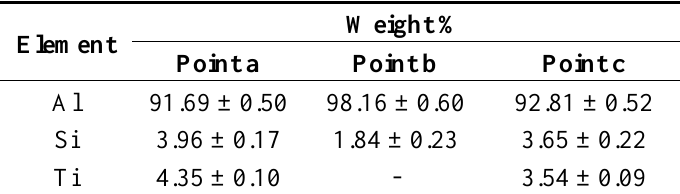
Figure 6. TEM image of A356 alloy after the modification process by TiCN nanoparticles. Table 2. EDS analysis results of the treated A356 alloy.